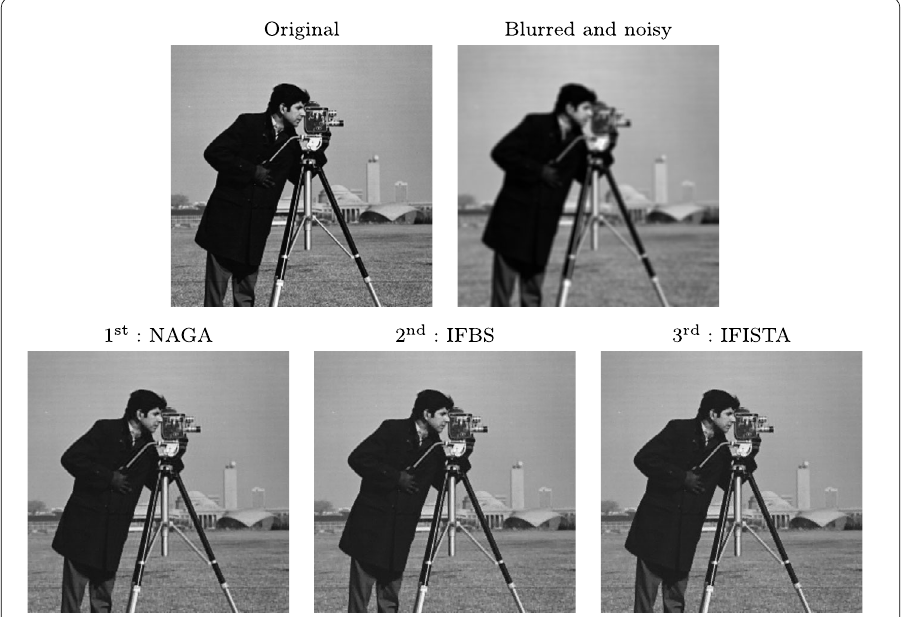
Figure 9 Top three fast convergence with good performance for deblurring of Cameraman